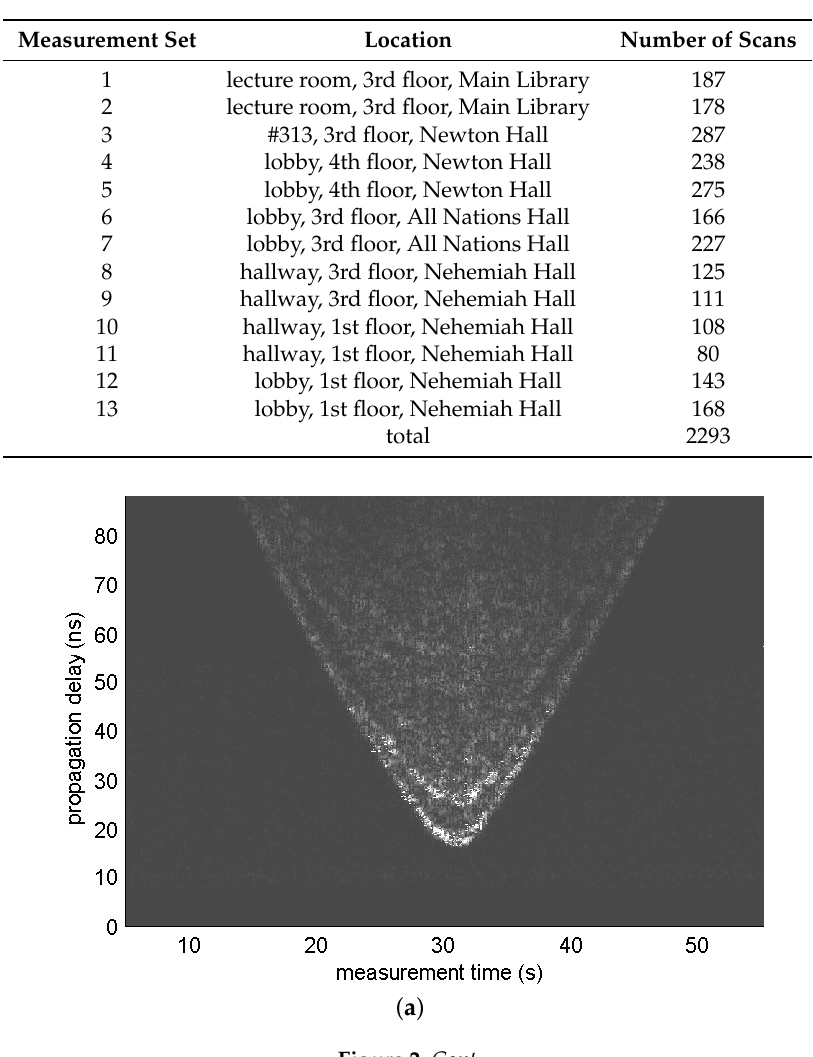
Table 1. Measurement environments. Measurements were taken in the lobbies, hallways, and lecture rooms of the university